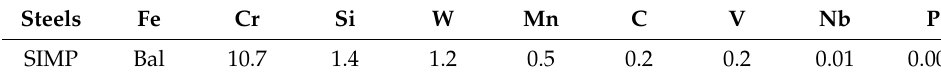
Table 1. Nominal composition of SIMP steel (wt.%).